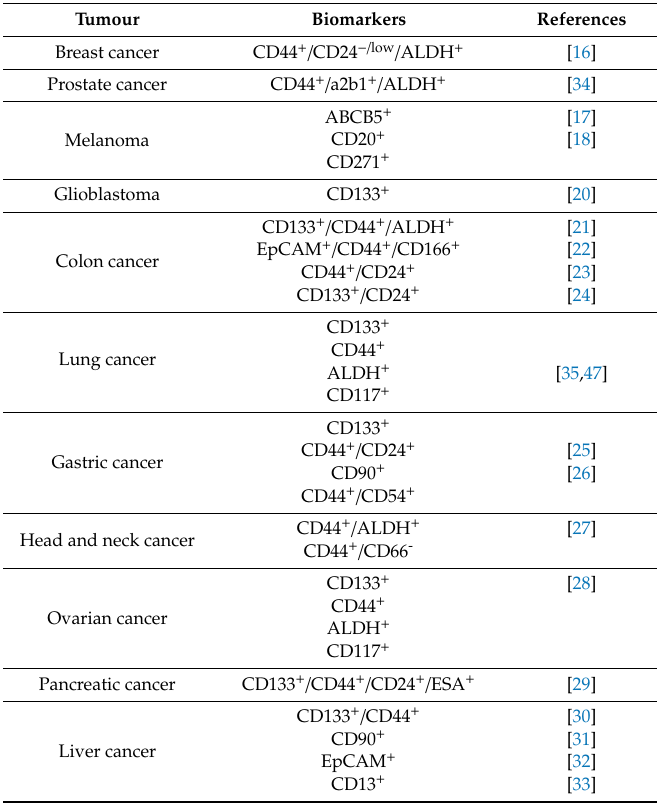
Table 1. Cell surface markers (solid tumours) that are used for the identification and isolation of CSCs.